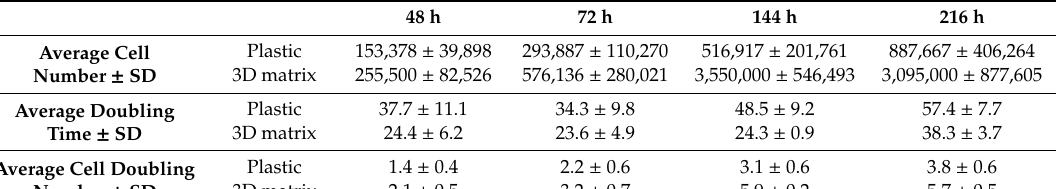
the 3D matrix, cells are dispersed homogeneously and exhibit a thinner spindle-like morphology ( b2 , 72 h).